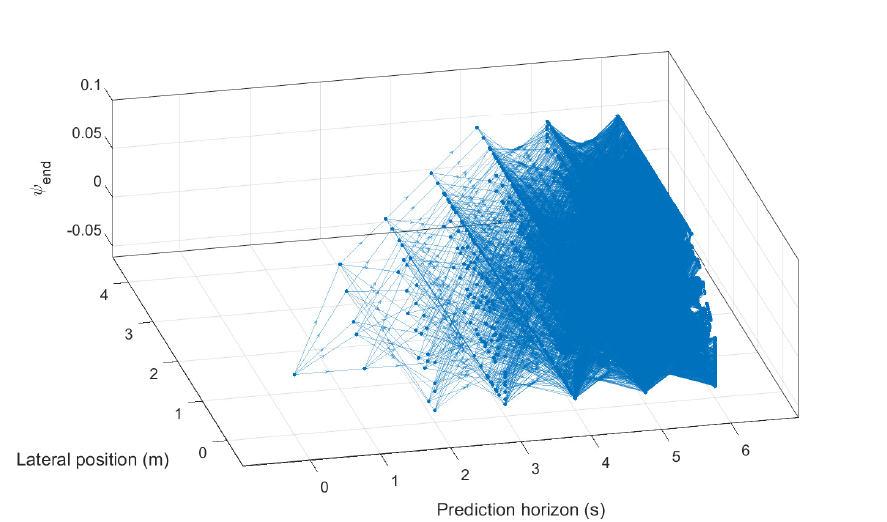
Figure 4. Graph used during the motion-planning process.